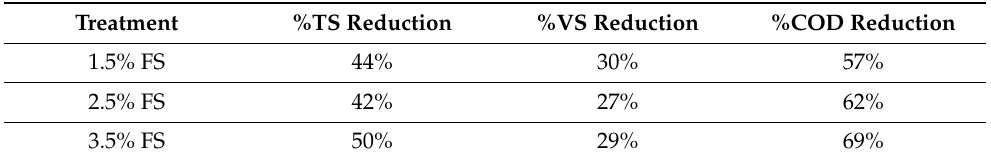
Table 4. Percent reduction in fish sludge mass of total solids (TS), volatile solids (VS), and chemical oxygen demand (COD) post